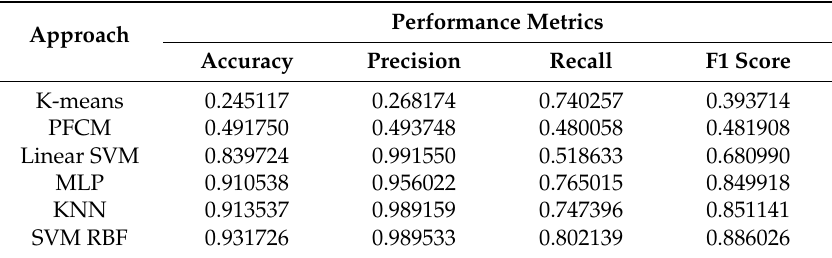
Table 5. Summary of smoking detection algorithms.